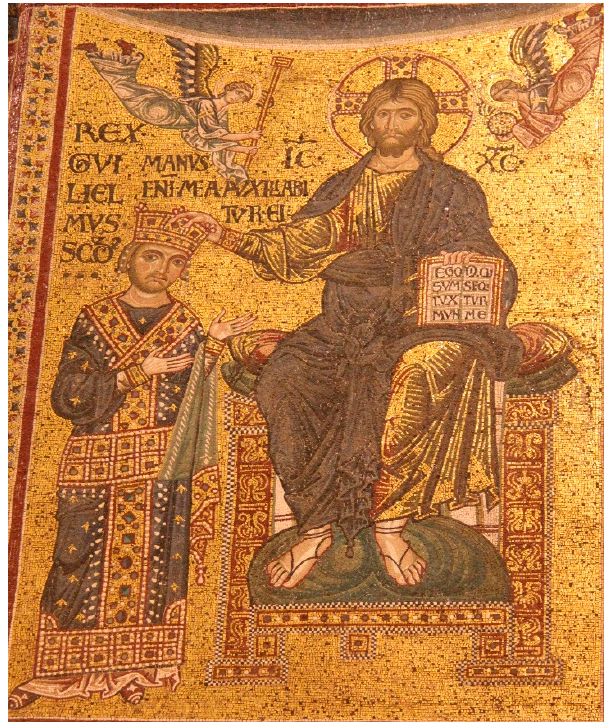
Figure 3. Christ crowning William II of Hauteville , mosaic, 1177–1183. Monreale, Cathedral, Presbytery, Choir. Photo taken by author.